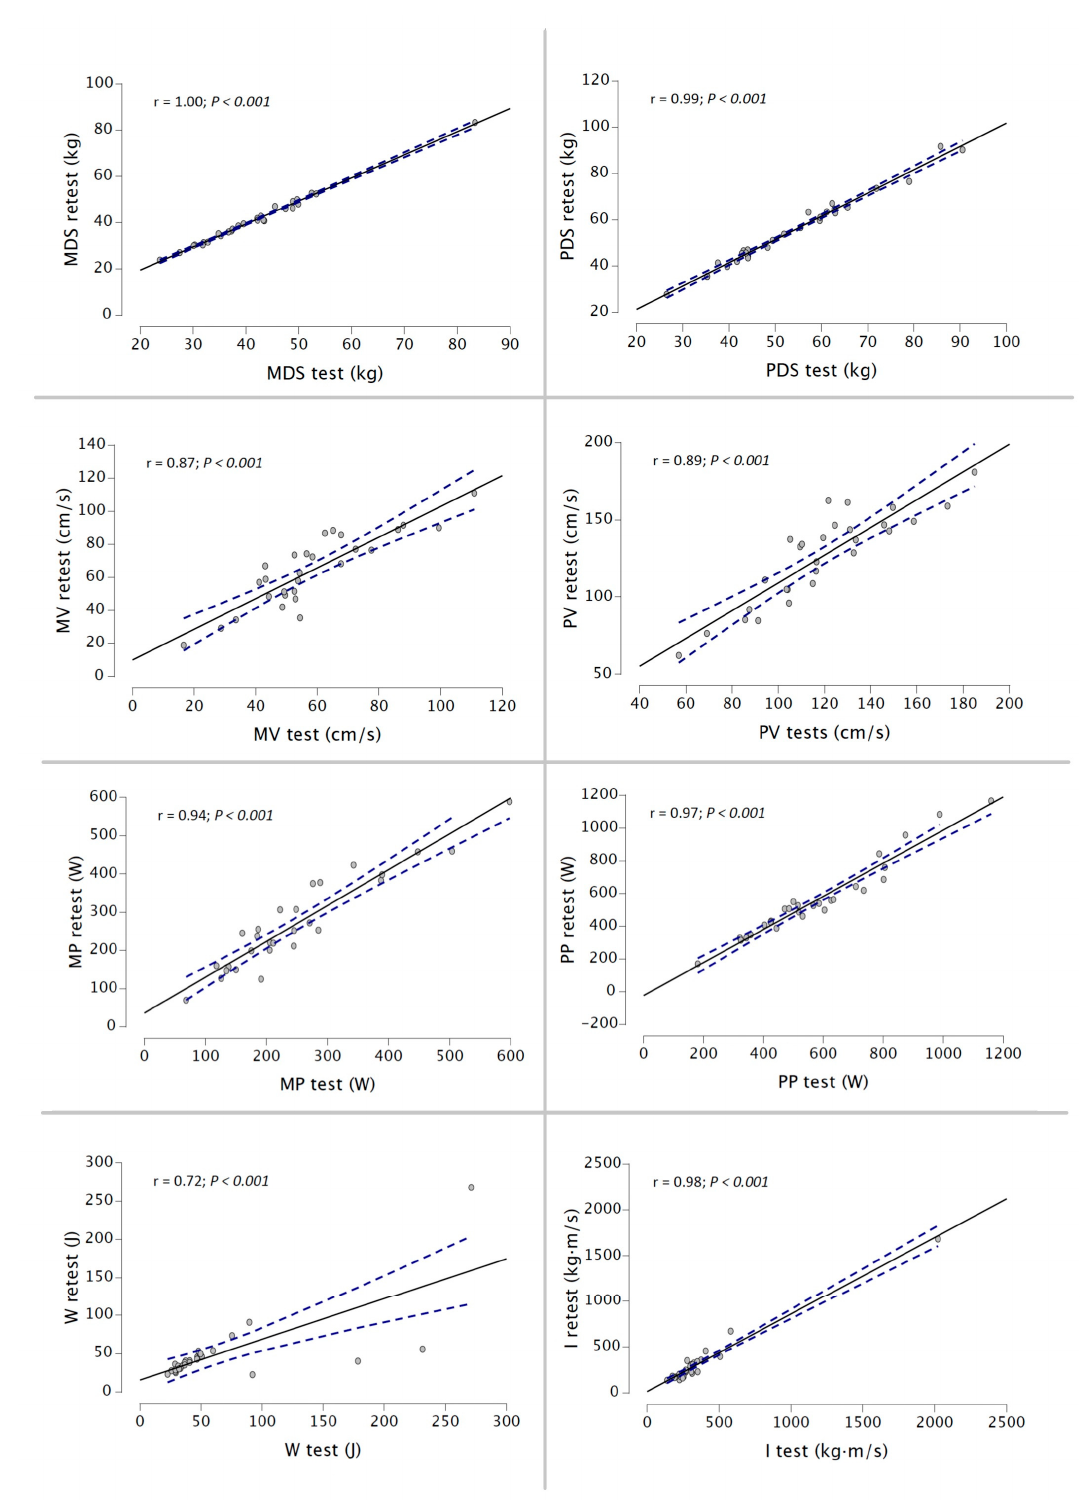
Figure 5. Relationship between MDS, PDS, MV, PV, MP, PP, W, and I between both testing sessions during 50% 1RM protocol using a DEMF.